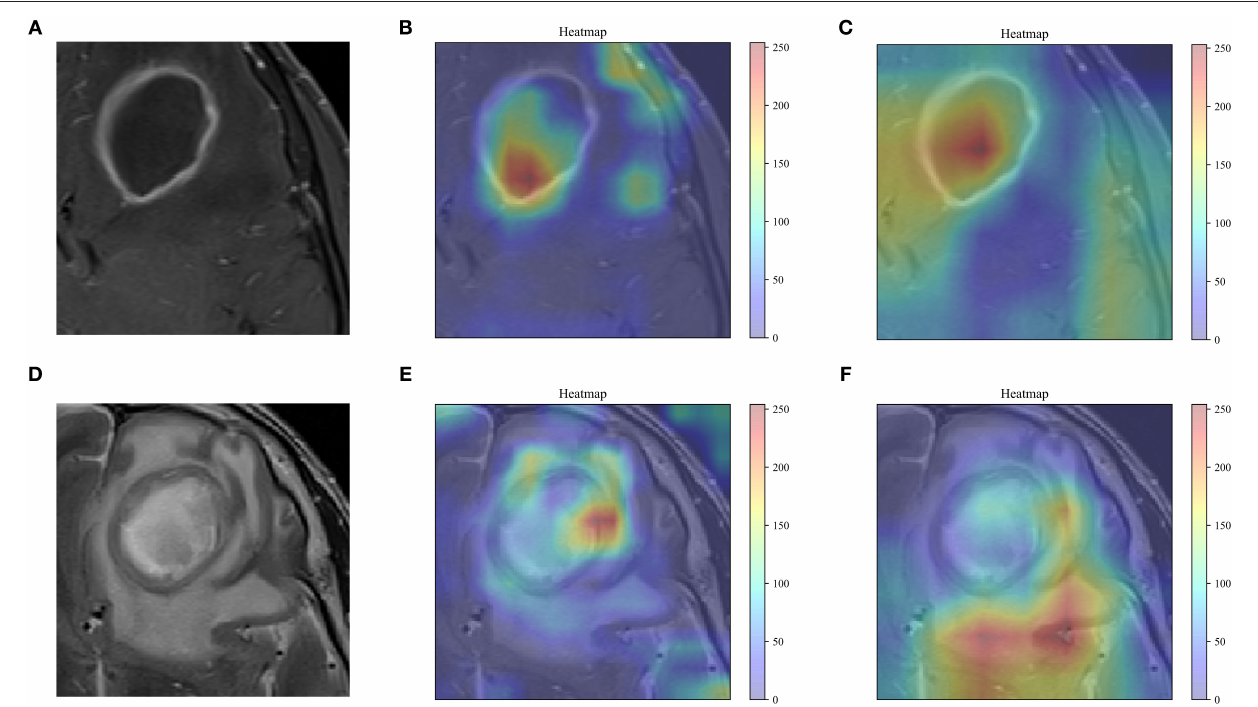
FIGURE 5 | Feature visualization. (A,D) The grayscale T1WI, T2WI, and the corresponding heat map are shown, and the red areas indicating greater weighting, with color bars on the right side of the plot. (B,E) , the feature map of the last convolutional layer in the VGG-19 model. (C,F) , the feature map of the last convolutional layer in the Resnet-50 model.